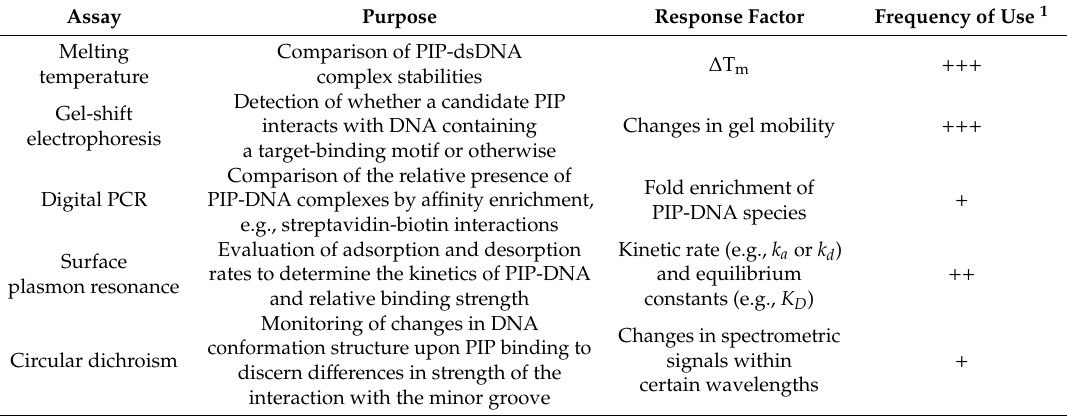
Table 1. Common biophysical assays used to assess pyrrole-imidazole polyamide (PIP)-DNA binding in situations where one DNA sequence interacts to multiple PIPs or vice versa. “Response factor” describes the primary type of measurement collected for evaluating PIP-binding specificity in relation to o ff -target